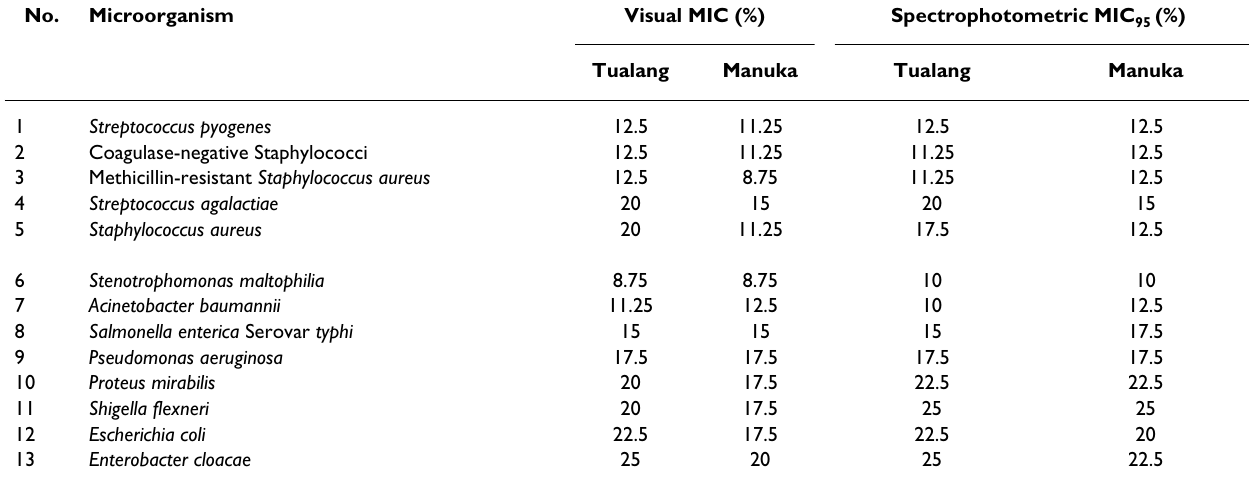
Table 1: MIC values (%) determined by visual inspection and spectrophotometric measurement No. Microorganism Visual MIC